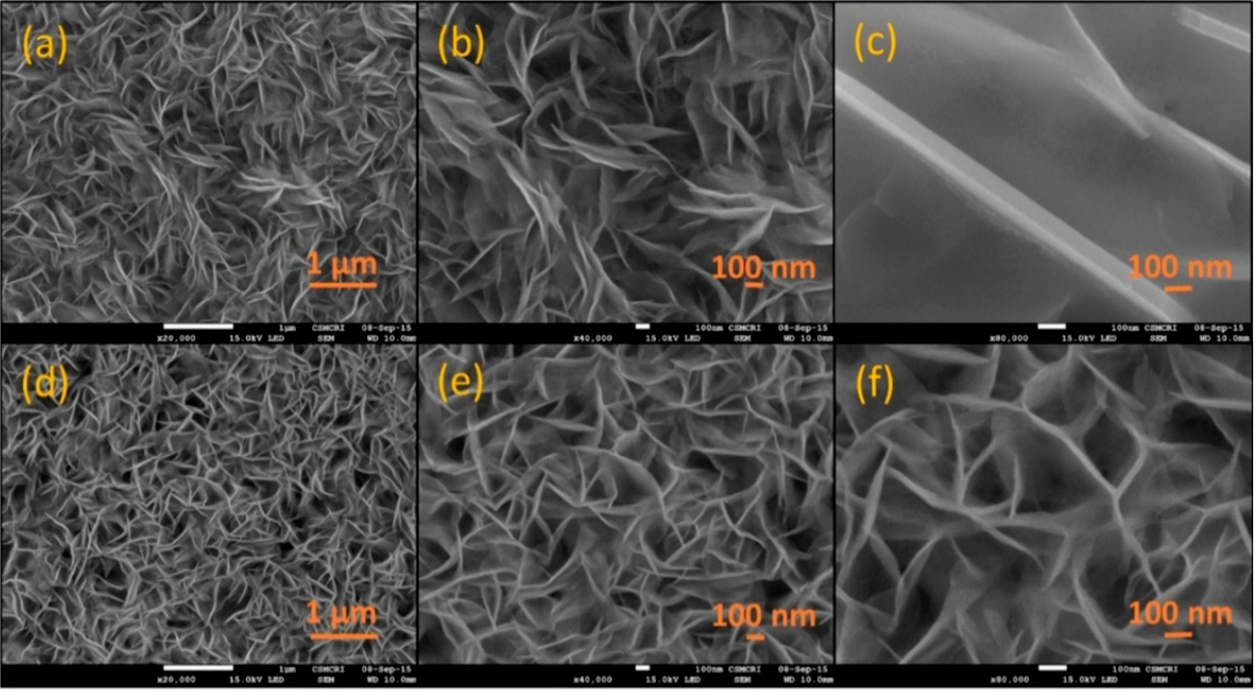
Figure 4. SEM images at different magnifications of prepared graphene oxide; ( a ) GO1 at 20 Kx; ( b ) GO1 at 40 Kx; ( c ) GO1 at 80 Kx; ( d ) GO2 at 20 Kx; ( e ) GO2 at 40 Kx; ( f ) GO2 at 80 Kx.